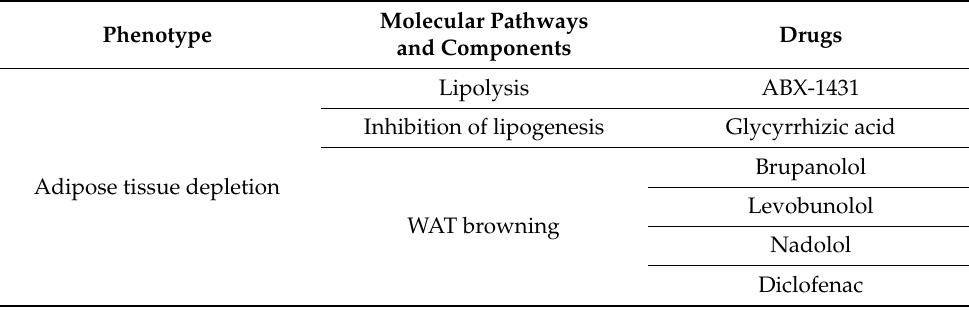
Table 4. Molecular pathways and respective drugs involved in adipose tissue